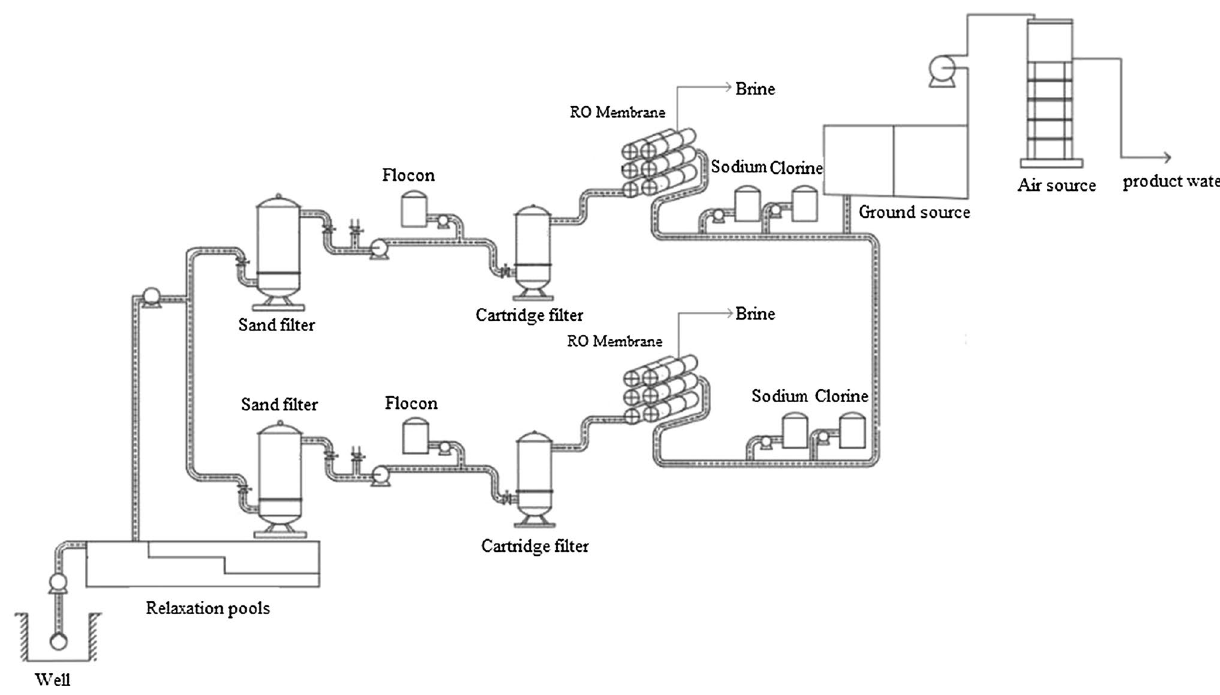
Fig. 1 Schematic of the Chabahar Maritime University reverse osmosis desalination plant